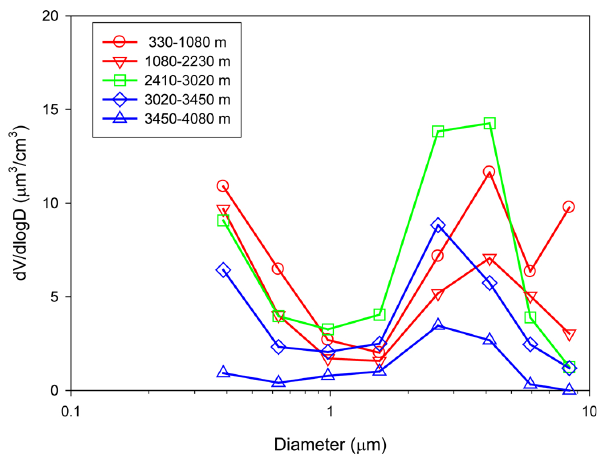
Fig. 7. Volume size distributions in classified layers below 4.1km. Data obtained from the OPC sonde, 19 April 2008.